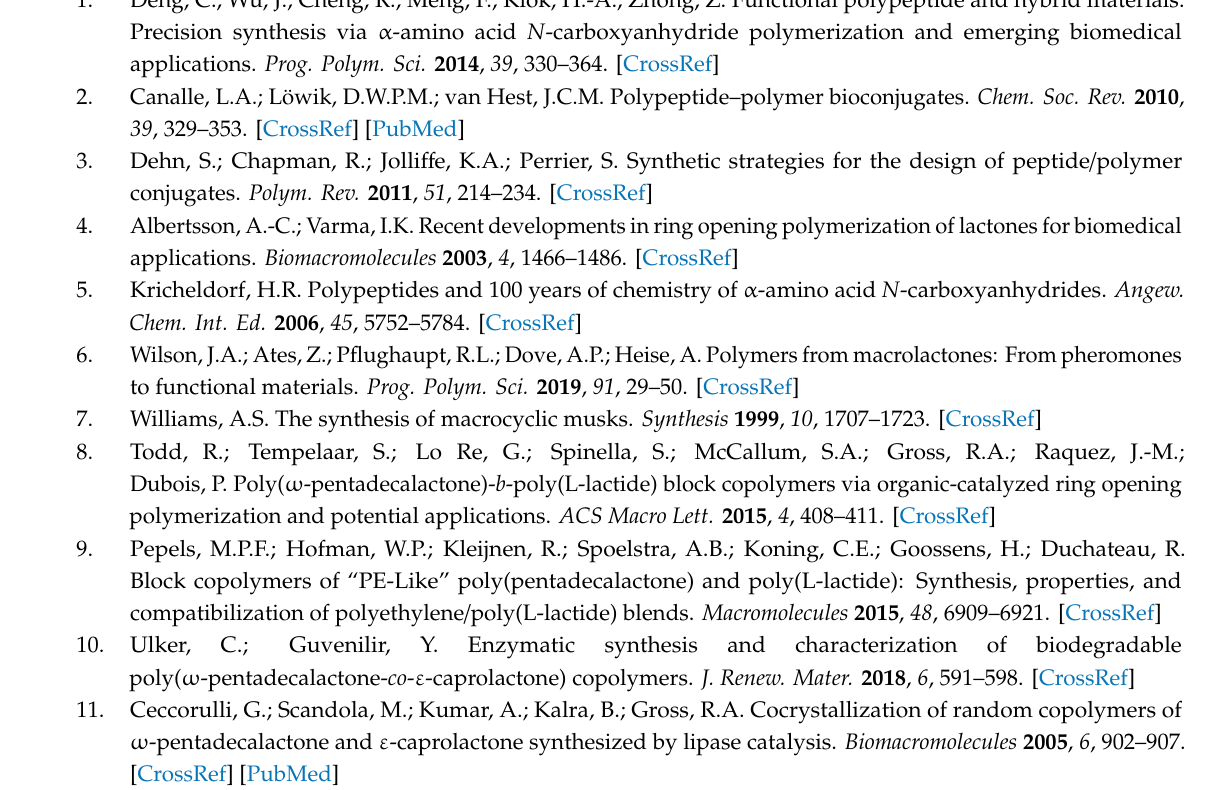
Figure S1: 1 H NMR (a) and 13 C NMR (b) of the P(Gl 13 - r -PDL 87 ) copolyester registered in CDCl 3 ; Figure S2: 1 H NMR (CDCl 3 ) of the P(Gl x - r -PDL y ) copolyesters series; Figure S3: 13 C NMR spectra of Gl and PGl highlighting the characteristic peaks of the di ff erent isomers used for quantification; Figure S4: TGA traces (a) and derivative curves (b) of the P(Gl x - r -PDL y ) copolyesters; Figure S5: 1 H NMR (CDCl 3 ) spectra of the P[(Gl-BAET) 13 - r -PDL 87 ] (a) and P[(Gl-NH 2 ) 13 -r -PDL 87 ] (b); Figure S6: GPC curves of the P[(Gl x - r -PDL y )- g -(LGlu) z ] copolymers. Peaks observed (CDCl 3 / TFA) spectra of the P[(Gl 48 - r -PDL 52 )- g -(BLG) 2 ] (a), and P[(Gl 48 - r -PDL 52 )- g -(LGA) 2 ] (b); Figure S8: TGA traces (a,b) and derivative curves (a’,b’) of the P[(Gl x - r -PDL y )- g -(BLG) z ] and P[(Gl x - r -PDL y )- g -(LGA) z ] copolymers; FigureS9: 1800–1500cm − 1 regionofFTIRspectraofP[(Gl 13 - r -PDL 87 )- g -(BLG) 10 ](a)andP[(Gl 48 - r -PDL 52 )- g -(BLG) 2 ] (b) at di ff erent temperatures over the 20–200 ◦ C range; Figure S10: evolution of the WAXS (a) and SAXS (b) profiles recorded from P[(Gl 48 - r -PDL 52 )- g -(BLG) 2 ] copolymer at heating over the 10–200 ◦ C range; Figure S11: evolution of the WAXS (a) and SAXS (b) profiles recorded from P[(Gl 48 - r -PDL 52 )- g -(LGA) 2 ] copolymer at heating over the 0–200 ◦ C range; Figure S12: SEM images of nanoparticles made of P[(Gl 13 - r -PDL 87 )- g -(BLG) 10 ]; Figure S13: DLS profiles (a) and plot used for determining the critical concentration (b) of micelles made of P[(Gl 13 - r -PDL 87 )- g -(LGA) 10 ]; Figure S14: chemical structure of DOX ·